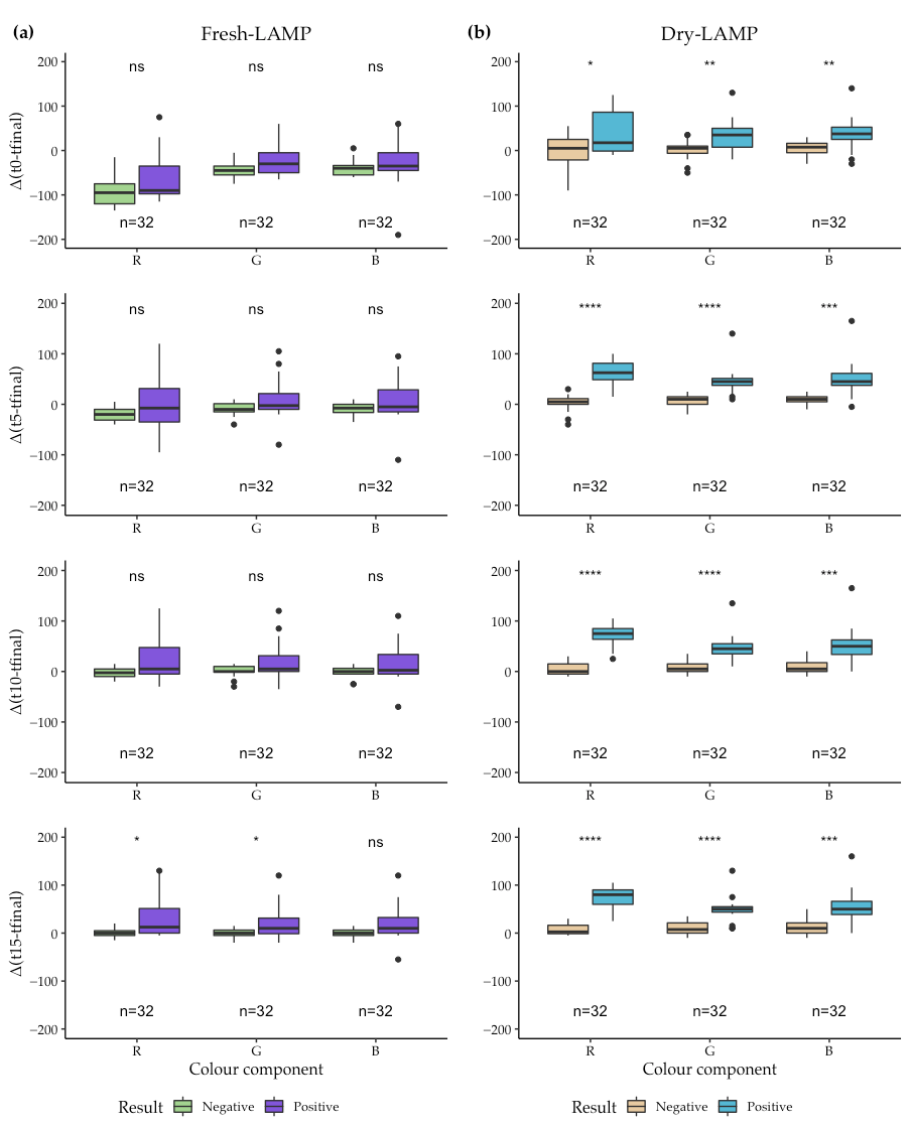
Figure 3. Differences between the final RGB values and the RGB values at 0, 5, 10 and 15 min for fresh-LAMP and dry-LAMP reactions measured by SMART-LAMP devices: ( a ) For fresh-LAMP and ( b ) dry-LAMP a total of 32 LAMP reactions ( n = 32) were performed: 8 LAMP reactions (including 4 PTC and $ NTC) for Schistosoma mansoni , S. haematobium , Strongyloides spp. and SARS-CoV-2. Mann-Whitney U test: n/s: non-significant, *: p - value ≤ 0.05, **: p - value ≤ 0.01, ***: p - value ≤ 0.001, ****: p - value ≤ 0.0001.